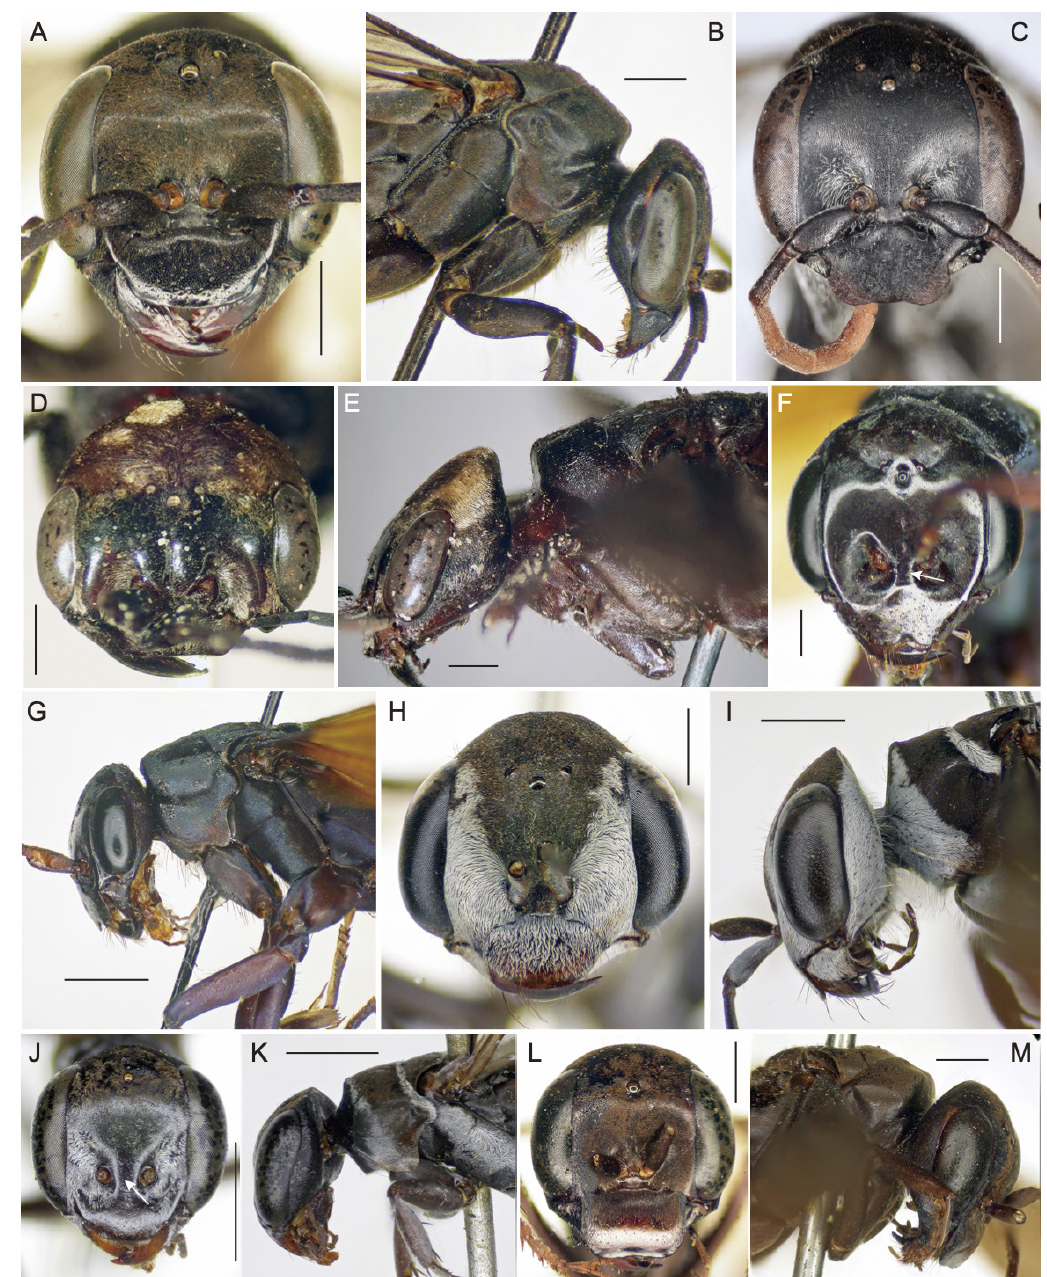
Fig. 11. Various taxa of the Entomobora -morphotype. A–B . Entomobora crassitarsis (Costa, 1887) (Pompilinae) (#56) (UMUT). C . Austroclavelia venator Evans, 1972, holotype (Pepsinae) (AUSTRALIA: Morialta, Mt Lofty Hills, South Australia; ANIC). D–E . Maurillus australis Smith, 1855, holotype (Pepsinae) (#59) (NHMUK). F–G . Hypoferreola sp. (probably “ Entypus ” cephalotes Saussure, 1867) (Pepsinae) (#58) (NHMUK), arrow in F indicates frontal bridge. H–I . Ctenostegus monstrosus Evans, 1976 (Pompilinae) (#54) (NHMUK). J–K . C. tenellus (Turner, 1910) (Pompilinae) (#55) (NHMUK), arrow in J indicates frontal bridge. L–M . Pedinpompilus ( Pedinpompilus ) salvatoris (Kohl, 1913) (Pompilinae) (#60) (NHMUK). A, C–D, F, H, J, L . Head, anterior view. B, E, G, I, K, M . Head and anterior part of mesosoma, lateral view. Numbers in parentheses after species names are specimen numbers in Supp. file 1. (C–E, Shimizu et al . 2021.) Scale bars = 1